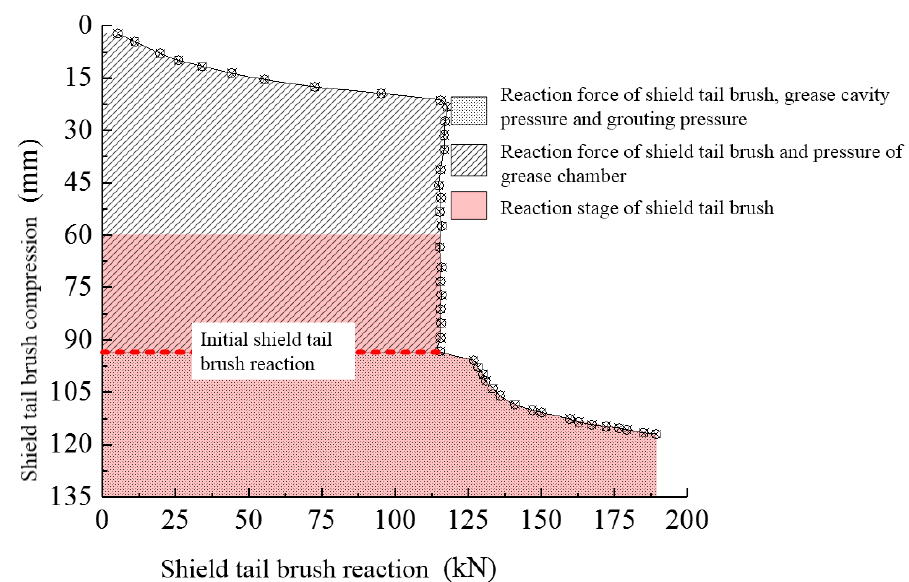
Figure 9. Reaction of shield tail.